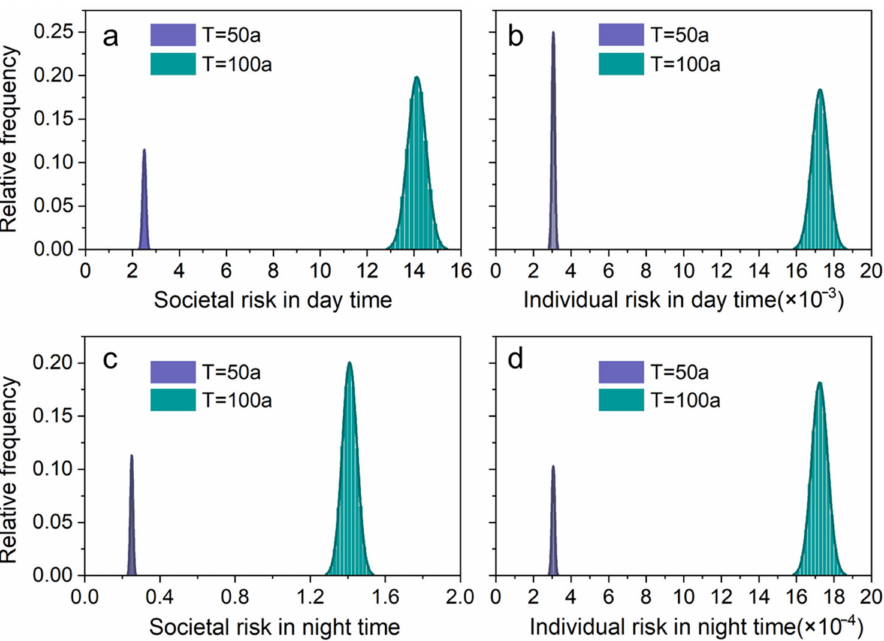
Figure 16. Societal risk and individual risk results under the two precipitation scenarios (return periods of 50 and 100 years): ( a ) societal risk in day time; ( b ) individual risk in day time; ( c ) societal risk in night time; ( d ) individual risk in night time.